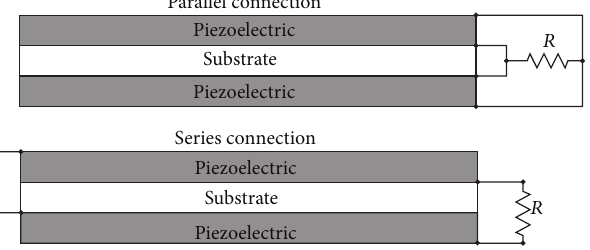
Figure 3: Parallel and series electrical